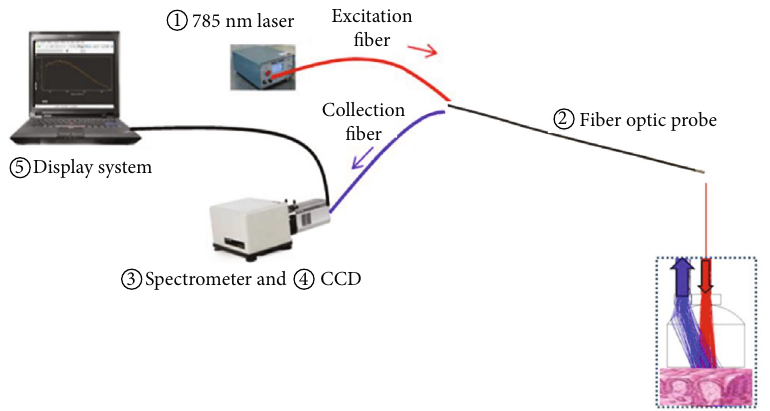
Figure 1: Fiber optic Raman spectroscopy